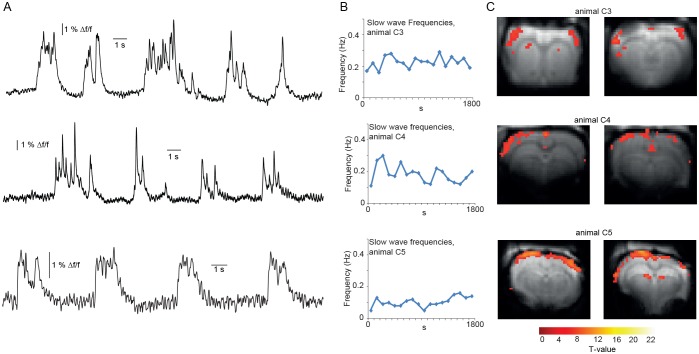
BOLD correlate upon FIR-based event-related fMRI analysis of additional datasets.(A) Excerpts of calcium traces acquired during fMRI measurements depicting slow calcium waves. (B) Frequencies of slow calcium waves within an imaging experiment. (C) Corresponding BOLD correlates upon slow calcium wave events.